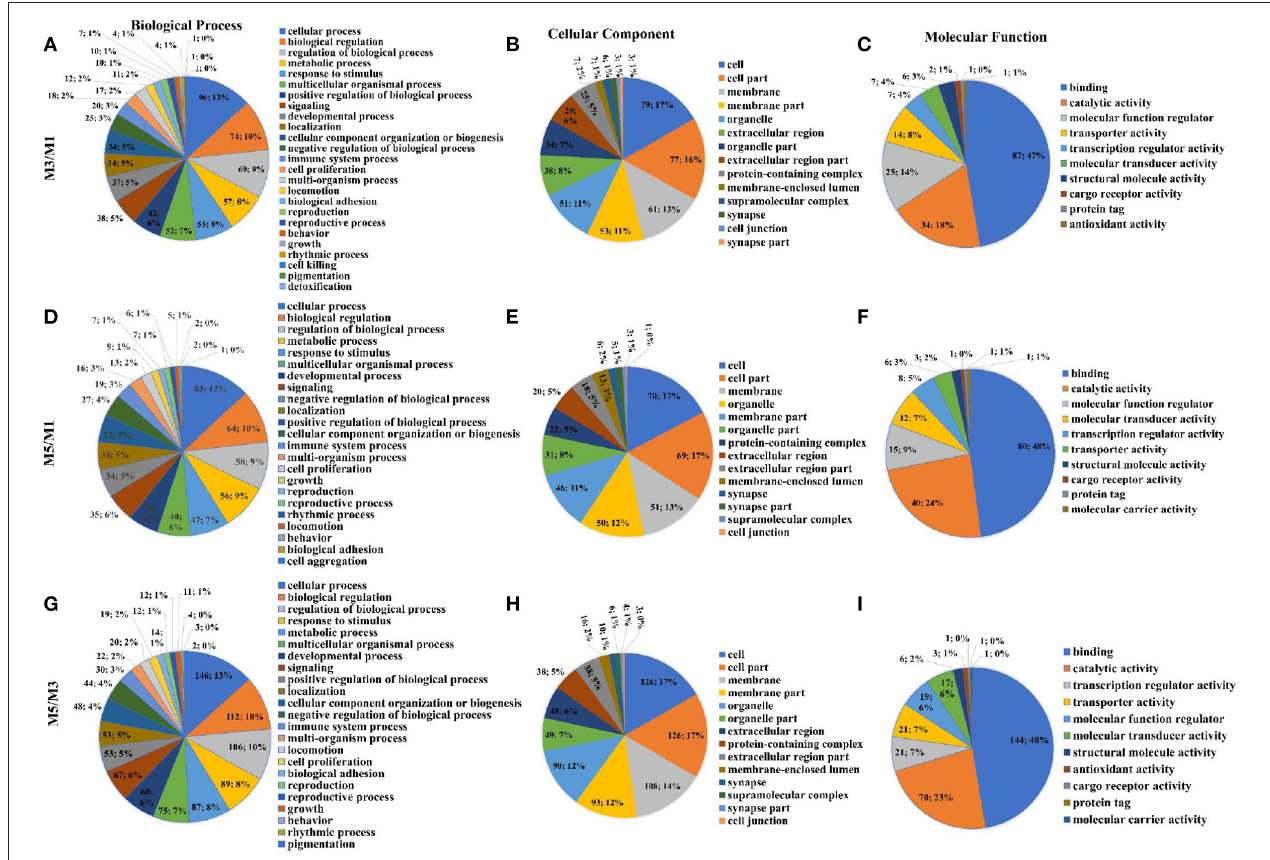
FIGURE 6 | Proportions of different gene ontology (GO) terms (level two) in the colon mucosa of pigs with different feeding regimens. Proportions of different GO biological process terms (A) , GO cellular component terms (B) , GO molecular function terms (C) between M3 and M1 groups. Proportions of different GO biological process terms (D) , GO cellular component terms (E) , GO molecular function terms (F) between M5 and M1 groups. Proportions of different GO biological process terms (G) , GO cellular component terms (H) , GO molecular function terms (I) between M5 and M3 groups. M1, one meal per day; M3, three meals per day; M5, five meals per